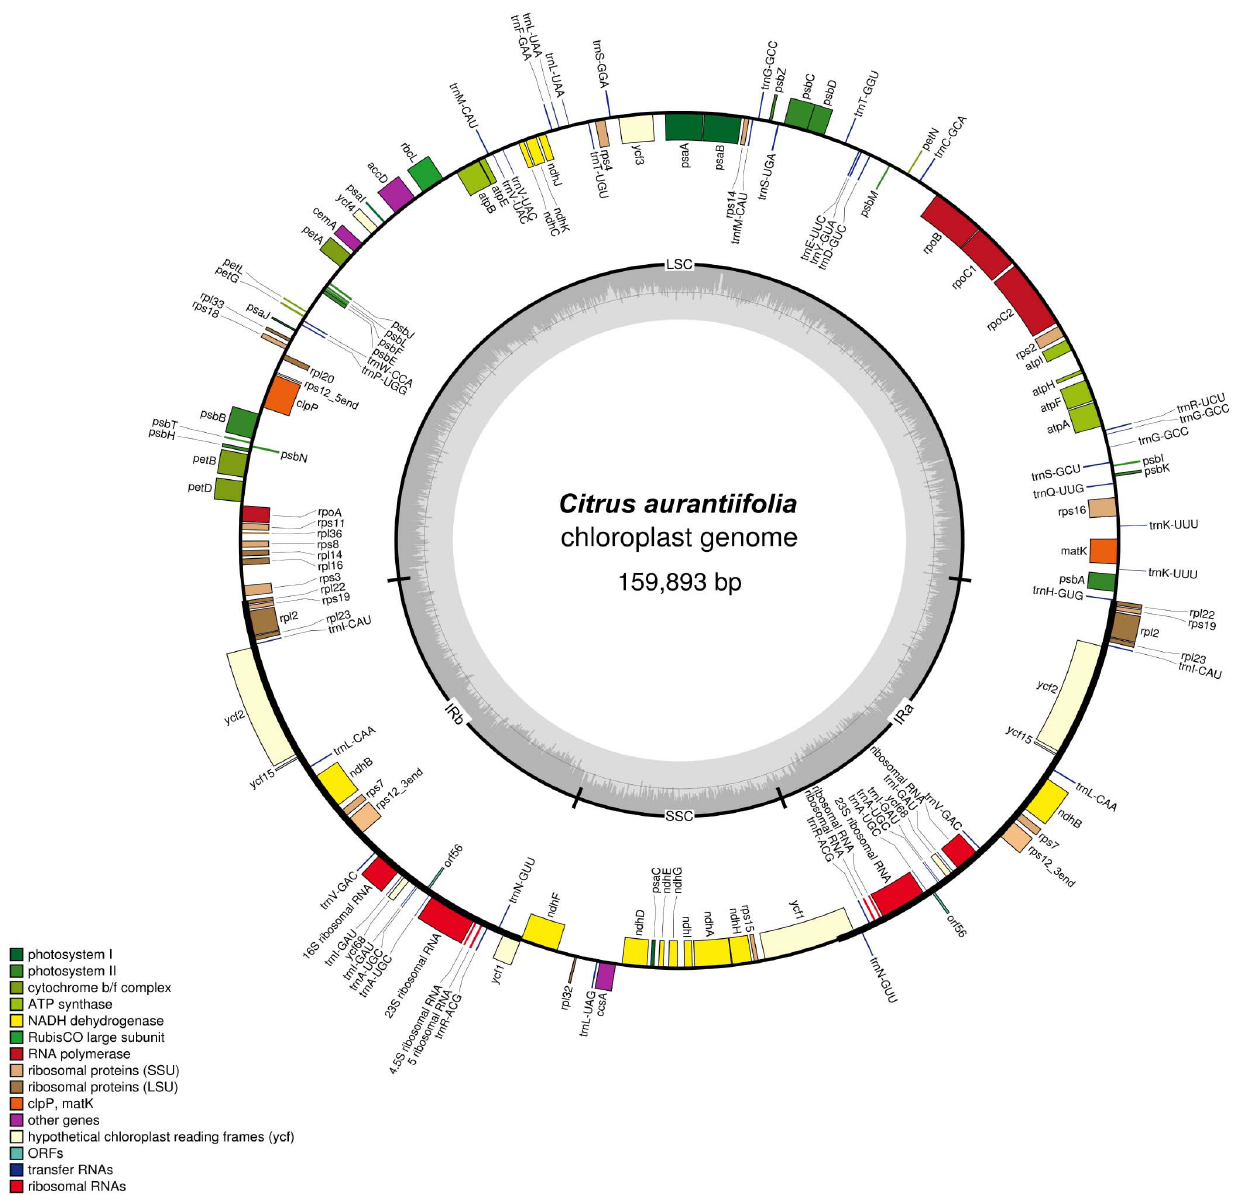
Figure 1. Chloroplast genome map of Citrusaurantiifolia . Gene drawn inside the circle are transcribed clockwise, whereas those outside are counterclockwise. The within-genome GC content variation is indicated in the middle circles.